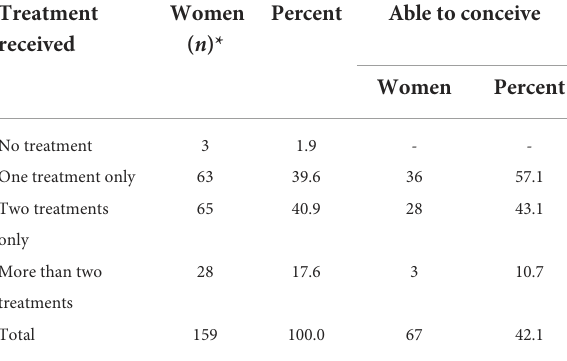
TABLE 2 Percentage of women received treatment in different orders and